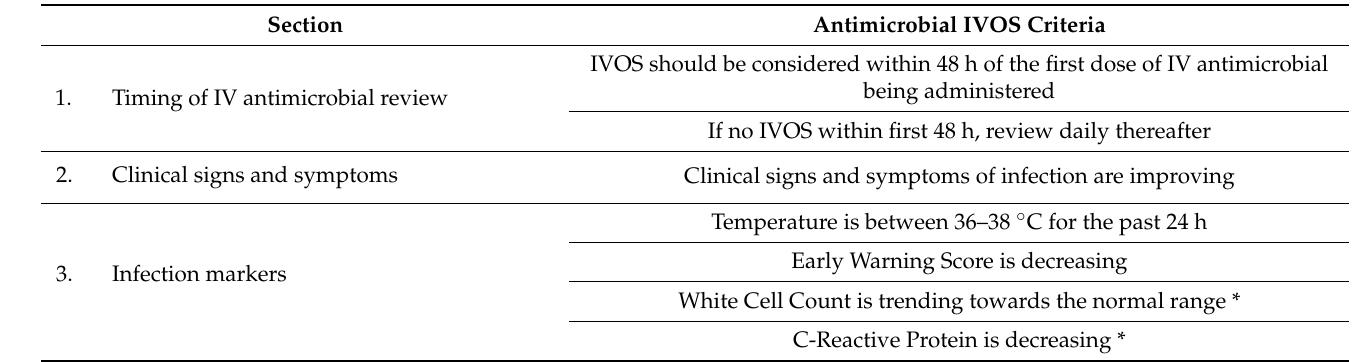
Table 5. Antimicrobial intravenous-to-oral (IVOS) criteria for timely switch categorised into 5